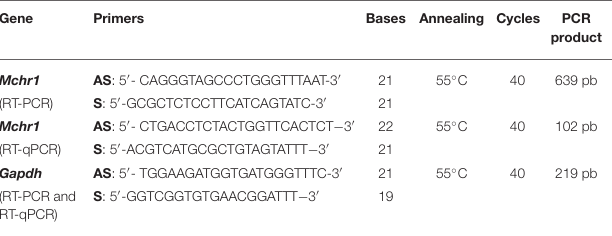
TABLE 1 | Primers used in RT-PCR and